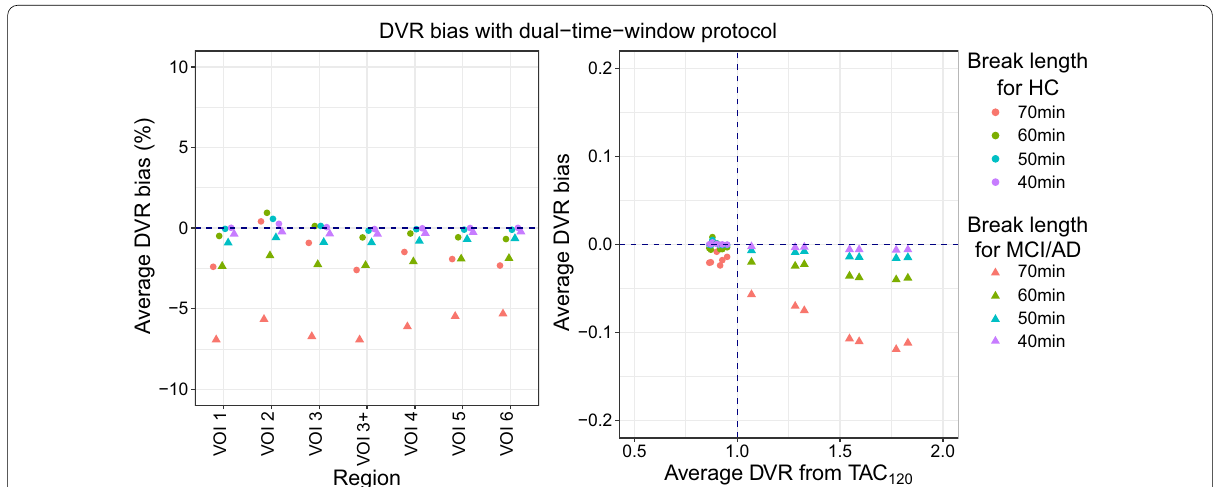
Fig. 2 Average DVR bias from dual-time-window TACs when compared to the 120-min uninterrupted TAC (TAC 120 ). The average relative bias for each region of interest is shown on the left panel, while the right panel shows the average DVR bias as function of DVR from TAC 120 . Diagnoses are indicated by data point shape and break length is indicated by